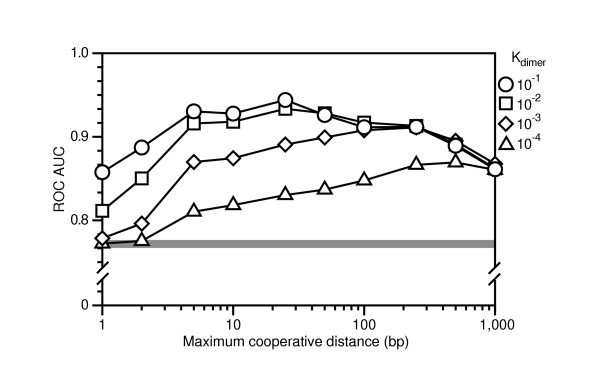
Modeling Fkh2p-Mcm1p cooperativity improves the ability to identify cell-cycle genes. Scores for the area under the receiver operating characteristic curve (ROC AUC) are plotted as a function of the maximum distance over which cooperative interactions between Fkh2p and Mcm1p are allowed to occur. Different symbols correspond to different assumed values for Kdimer, a parameter that specifies the strength of cooperative interactions (10-1 (circles), 10-2 (squares), 10-3 (diamonds) and 10-4 (triangles)). The horizontal gray line indicates the ROC AUC value in the absence of cooperative interactions with Mcm1p. All calculations were performed using the optimal regulatory region definition previously determined for non-cooperative binding (Gaussian weight function with mean = 250 base pairs (bp) and SD = 250 bp).